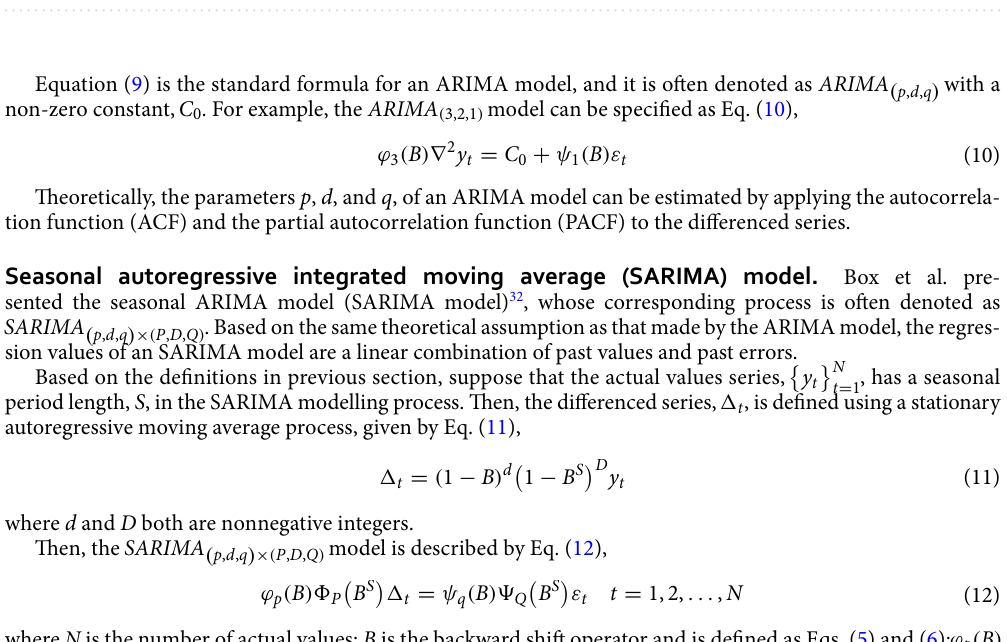
Table 6. Summary of ARMA model recognition